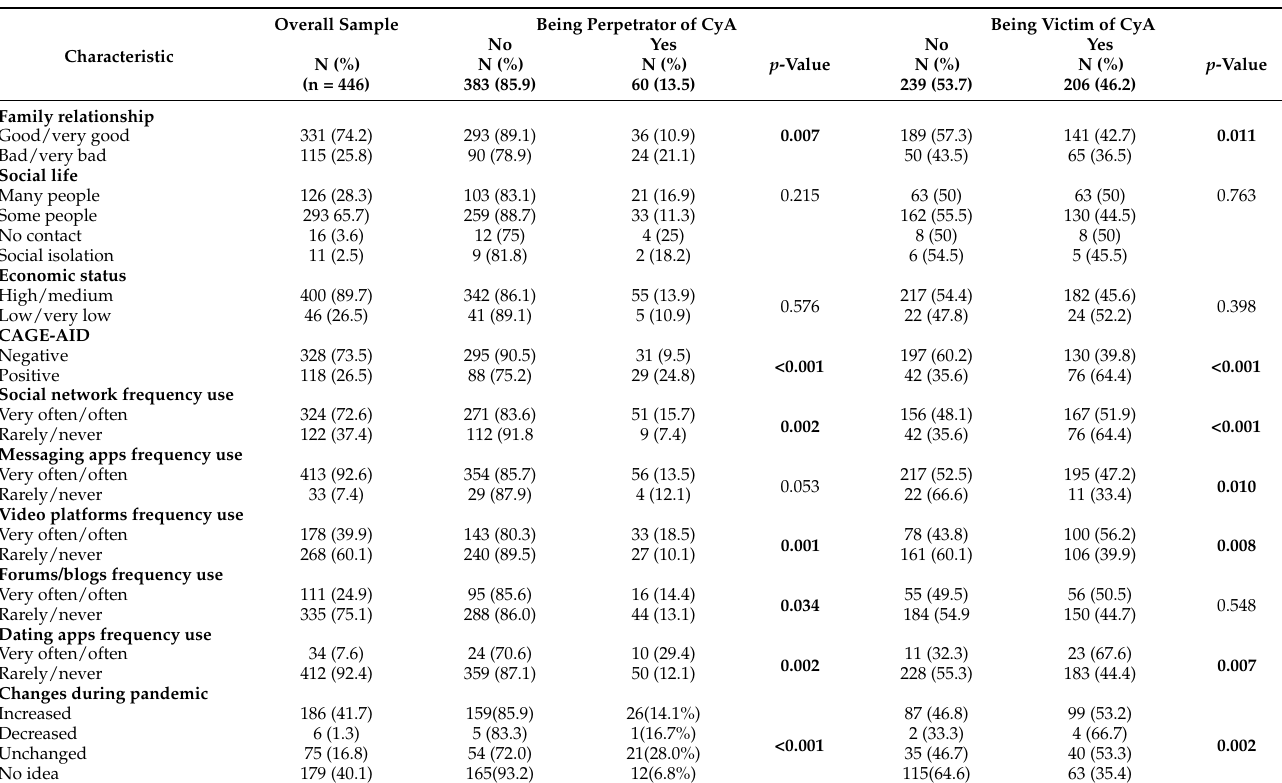
Table 2. Participants’ personal characteristics, online behavior, and relationships with primary